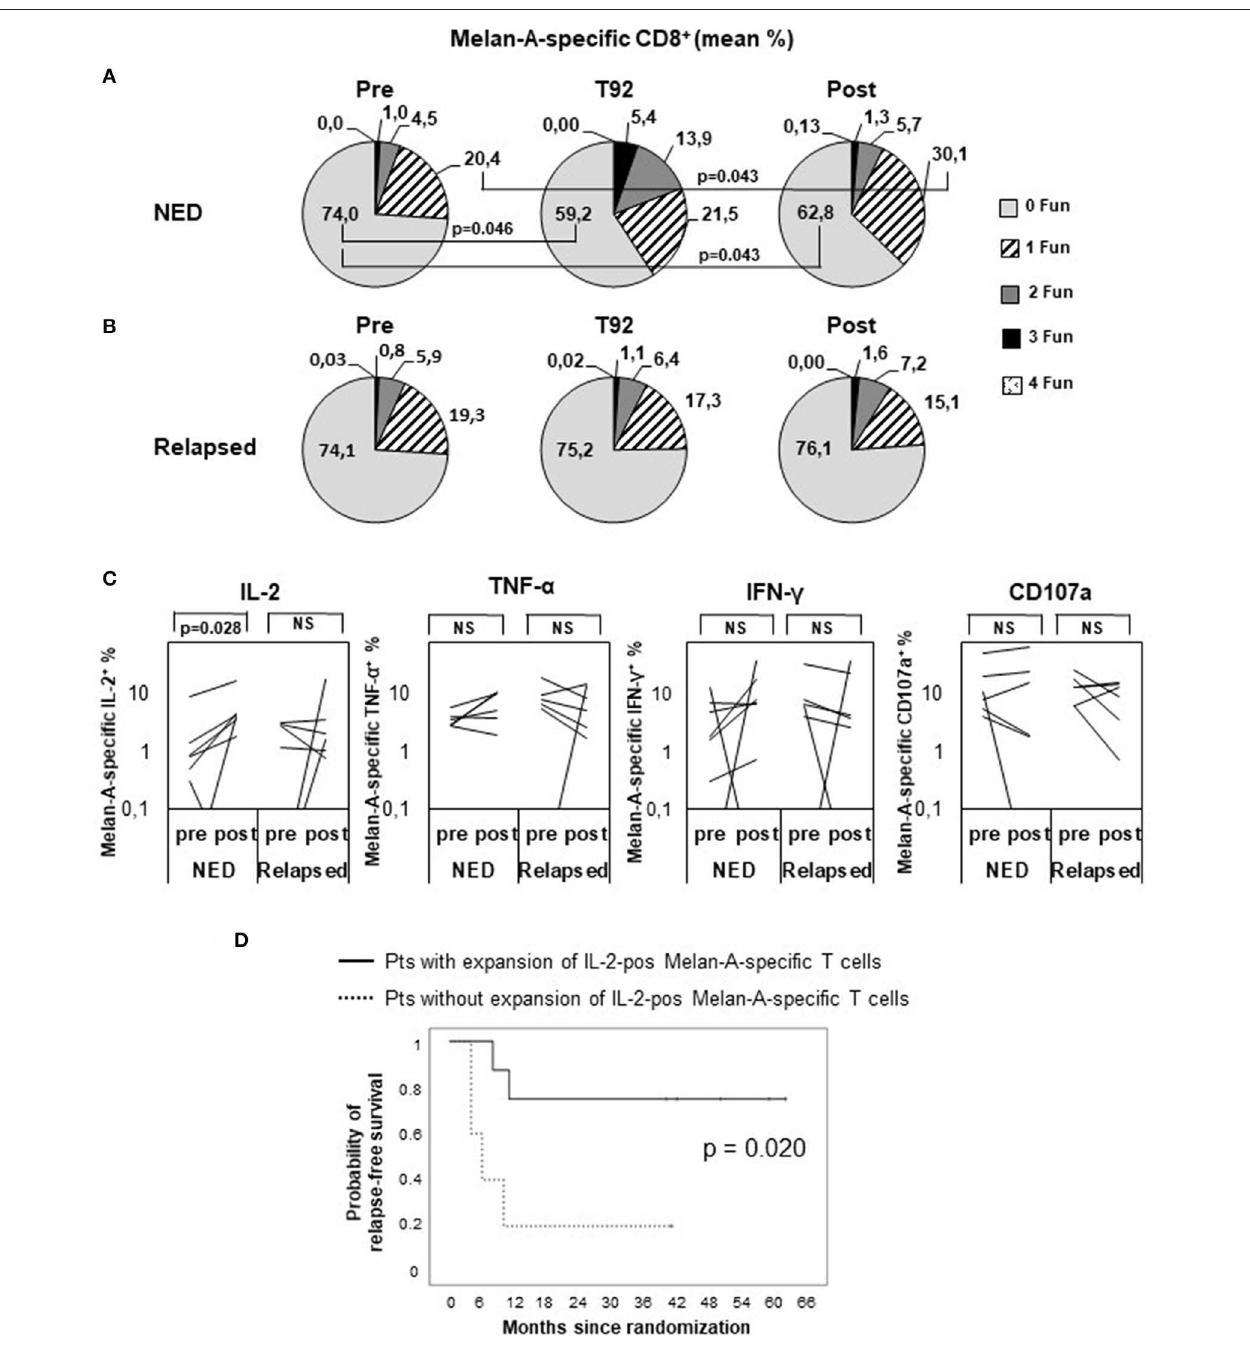
FIGURE 4 | Polyfunctional analysis of Melan-A–specific CD8 + T cells. Peripheral blood mononuclear cells were analyzed by multiparameter flow cytometry after 5h in vitro culture without peptide pulsing, followed by 1-h incubation with brefeldin A and monensin. CD8 + Melan-A tetramer–positive T cells were gated as shown in Supplementary Figure S1 and analyzed for their simultaneous expression of surface CD107a and intracellular IL-2, IFN- γ , and TNF- α . (A,B) Pie charts showing the proportion of cells expressing any combination of four (4 Fun), three (3 Fun), two (2 Fun), one (1 Fun), or zero (0 Fun) tested markers (CD107a, IL-2, IFN- γ , and TNF- α ). Data are expressed as mean percentage of CD8 + Melan-A tetramer–positive T cells. (A) Patients with no evidence of disease (NED). (B) Patients with disease recurrence (Relapsed). p values by Wilcoxon signed-rank test. (C) Variation of Melan-A–specific T cell percentage expressing intracellular IL-2, TNF- α , IFN- γ , or surface CD107a (logarithmic scale) between pretreatment and posttreatment (4 months) in patients with no evidence of disease (NED) ( n = 7) vs. relapsed patients ( n = 6). p values by Wilcoxon signed-rank test. (D) Kaplan–Meier plot comparing the relapse-free survival of patients (Pts) characterized, or not, by a twofold expansion of IL-2–positive Melan-A–specific T cells in post vs. pre samples. p value by log-rank test.